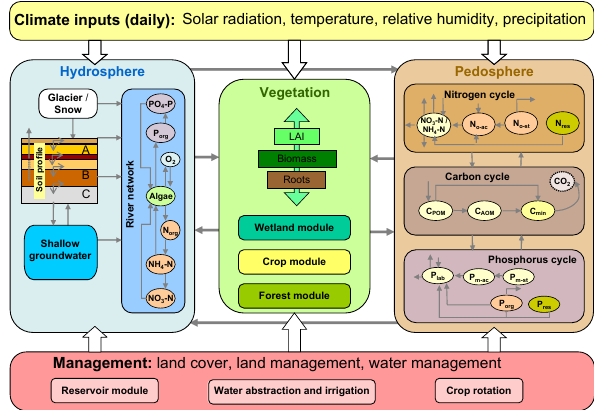
Fig. 2. Structure of the eco-hydrological model